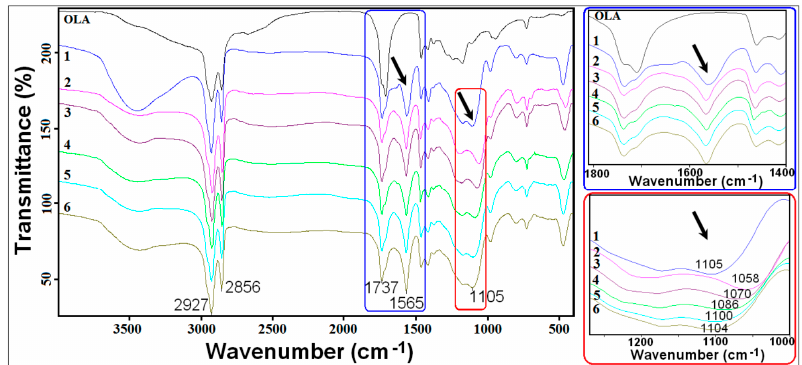
Figure 2. FT-IR spectra of ODTES/sodium silicate hybrids produced at different molar ratios. (The black arrows indicate the relevant peaks).